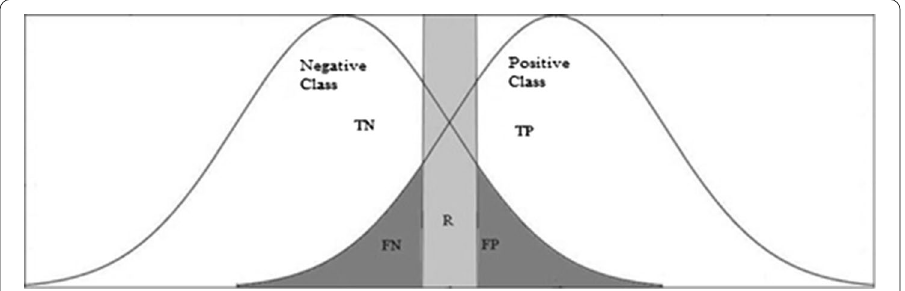
Fig. 3 Statistical distribution curves related to